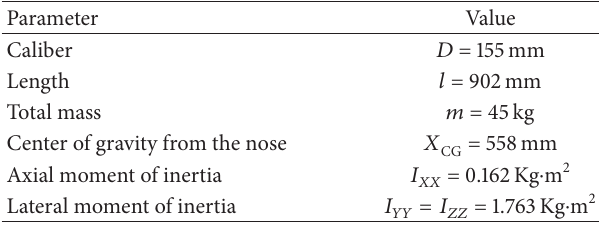
Table 1: Projectile physical